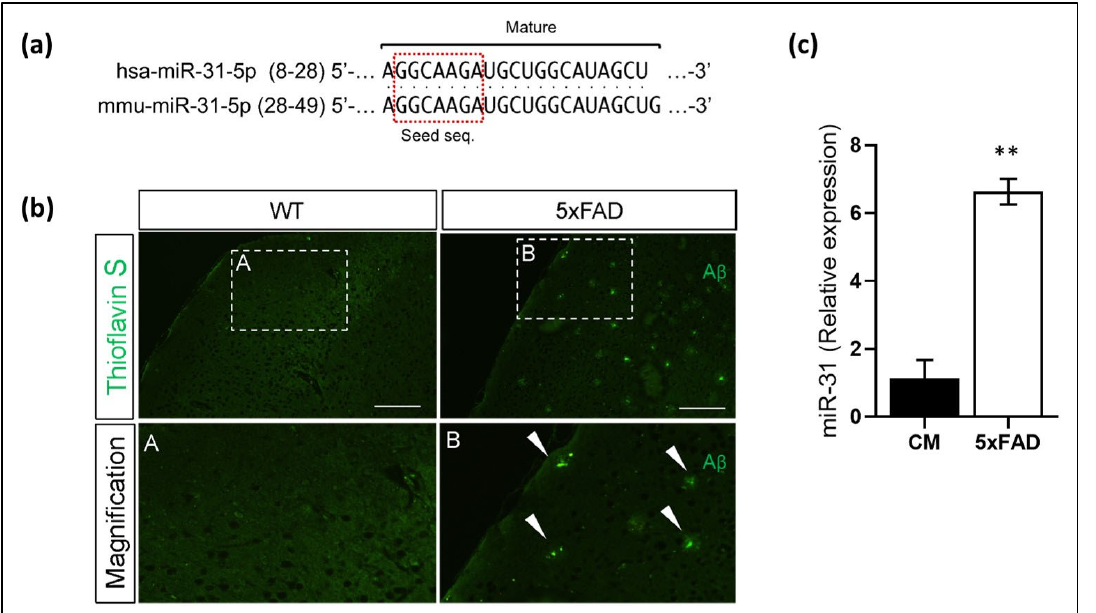
Figure 6. miR-31 could play an interesting role in AD. ( a ) Representation of the mature sequences of miR-31-5p in humans and mice. ( b ) Representative images of cortical A β aggregates in mice stained with Thioflavin S. Scalebar: 10 µ m ( c ) qPCR of miR-31-5p in mouse cortex. Relative miR-31 expression corresponding to the means ± SEM from three independent experiments. ** p < 0.01; (significantly different from cells transfected with the CM). A and B represent magnifications images of insets selected in WT and 5xFAD, respectively.